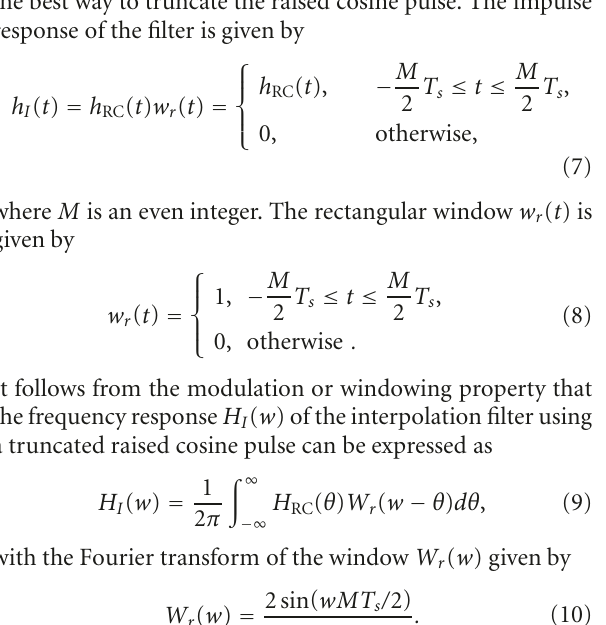
Figure 3: Peak amplitude of aliasing versus rollo ff factor for PRML